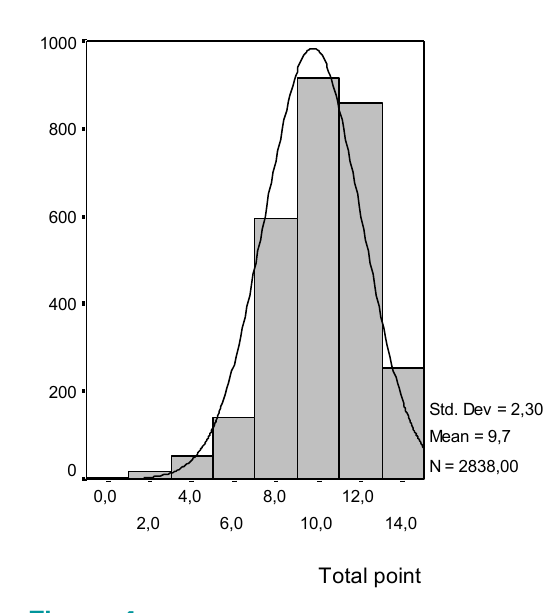
Figure 2 Distribution of general knowldge levels of the students about what kind of disease is AIDS.